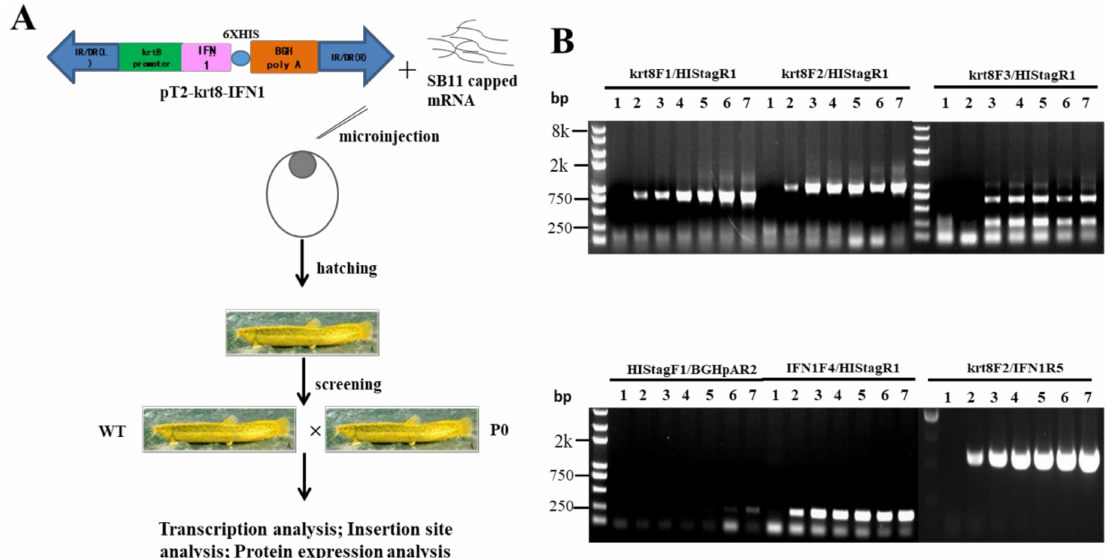
Figure 3. Generation of transgenic loach. ( A ) The strategy of generation of transgenic loach. ( B ) The sensitivity and specificity of seven primer pairs were determined in a 25 µ L volume containing 100 ng genomic DNA and transgenic plasmids pT2-krt8-IFN1 (0, 1, 5, 10, 20, 50 or 100 copies) as